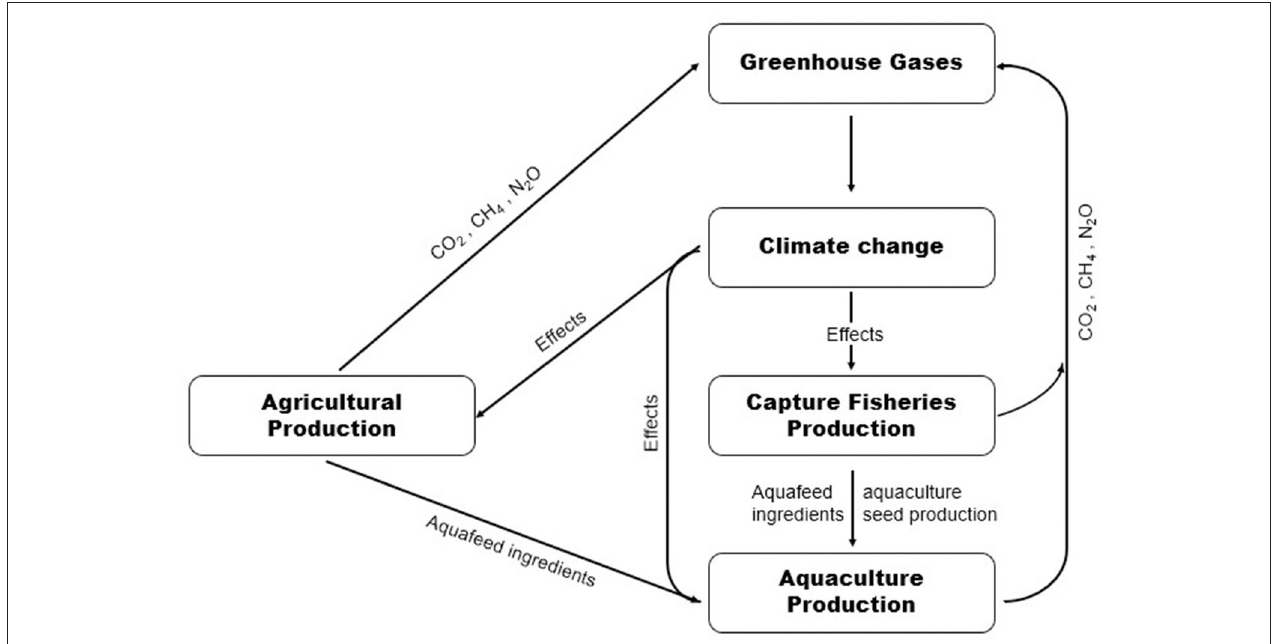
FIGURE 1 | A simple illustration of the direct and indirect pathways through which climate change will affect aquaculture production.